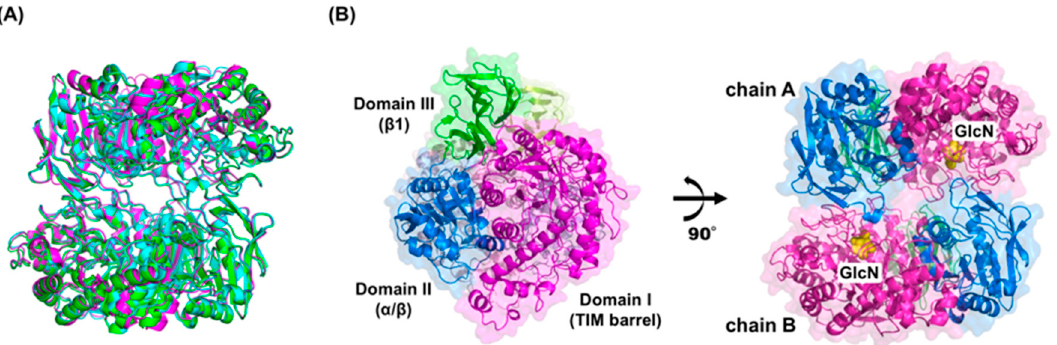
Figure 1. The overall structure of GlmA Tk . ( A ) The structural superposition of GlmA Tk (magenta), GlmA Ph (cyan), and GlmA Pf (green); ( B ) The dimer structure of GlmA Tk is presented in two views. GlmA Tk consists of a homodimer (chains A and B) and comprises three distinct domains (TIM-barrel: magenta, α / β : blue, β 1: green). The bound GlcN is represented by yellow van der Waals spheres. The